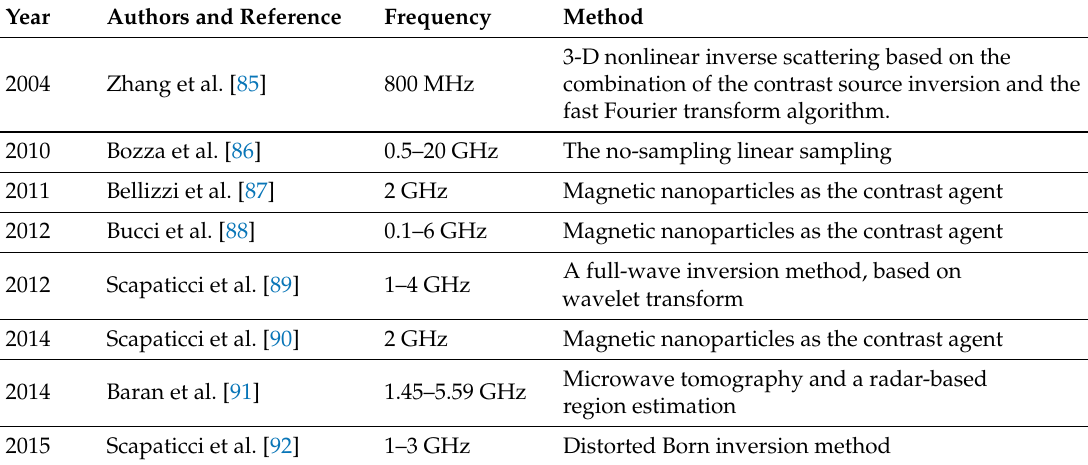
Table A2. A comparison between innovative algorithms and methodologies for breast cancer